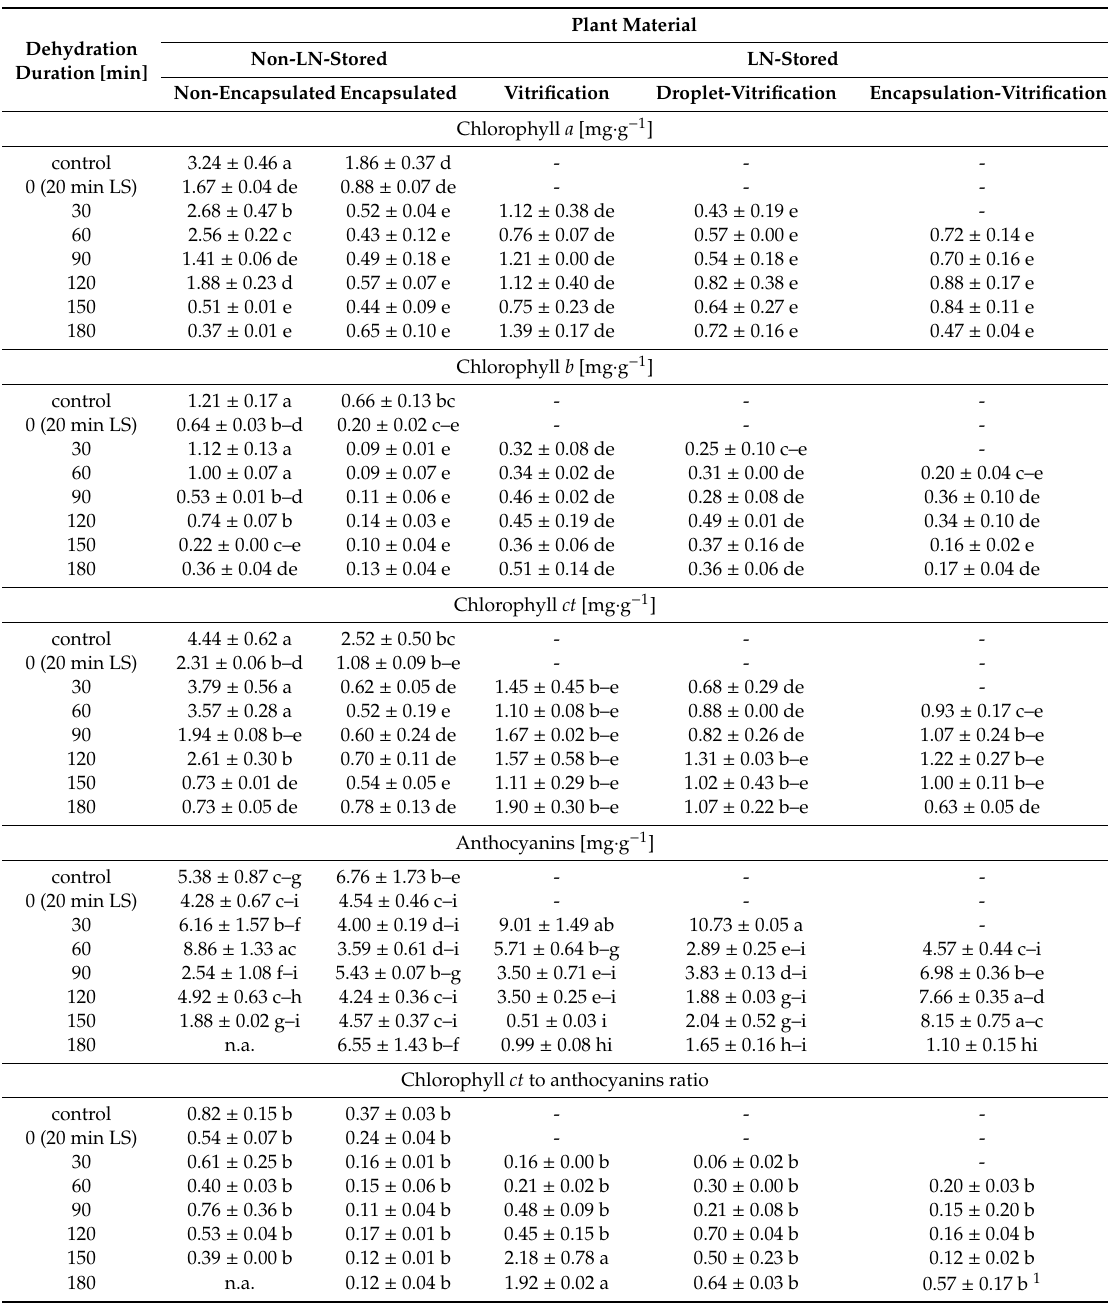
Table2. Influenceofthreecryopreservationtechniquesontheconcentrationofchlorophyll a , chlorophyll b , total chlorophyll ct , and anthocyanins in +/ − LN-stored shoot fresh matter [mg · g − 1 ] after 60 days of